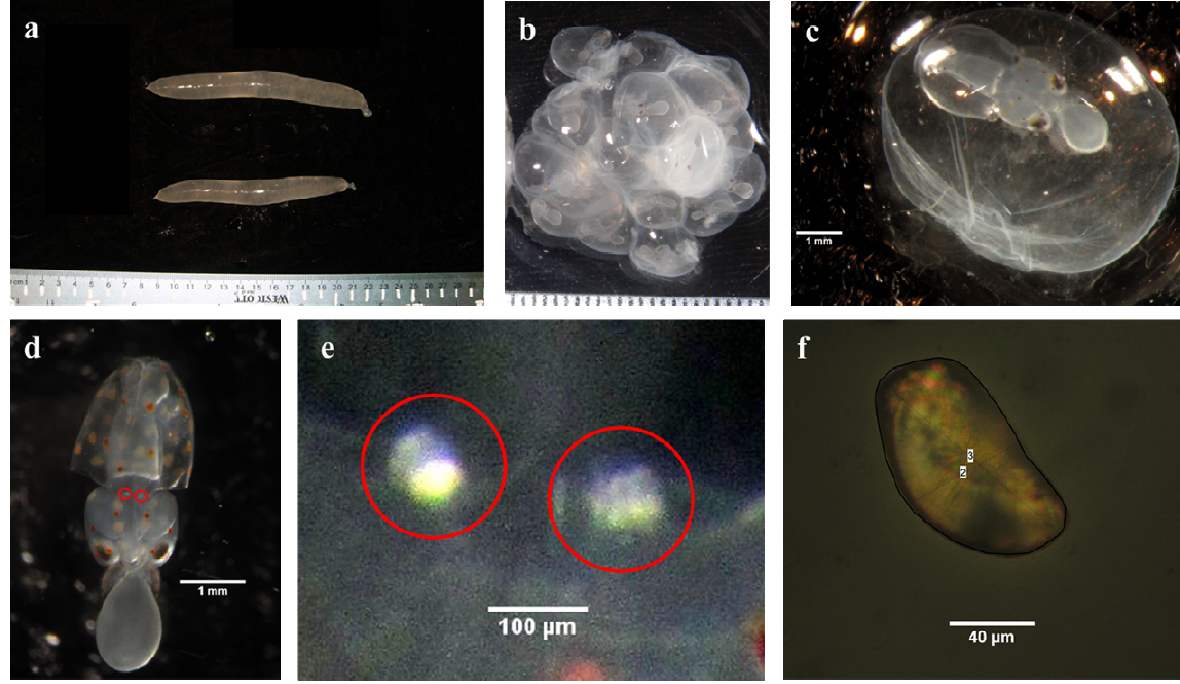
2. ( a ) Two squid-embryo capsules. Capsules are directly exposed to the environment, and each contains between 100 and 300 embryos. Ruler units are in cm; ( b ) Subsection of the capsule with the capsular membranes removed. Gelatinous material fills the interstitial space between the chorions and the capsular membranes; tick marks at the bottom of the image demarcate mm; ( c ) Chorion filled with perivitelline fluid and containing a squid embryo; ( d ) Squid embryo: statocysts are circled in red; ( e ) Statocysts are filled with endolymph fluid, and each contains a single statolith; ( f ) Embryonic statolith, made of